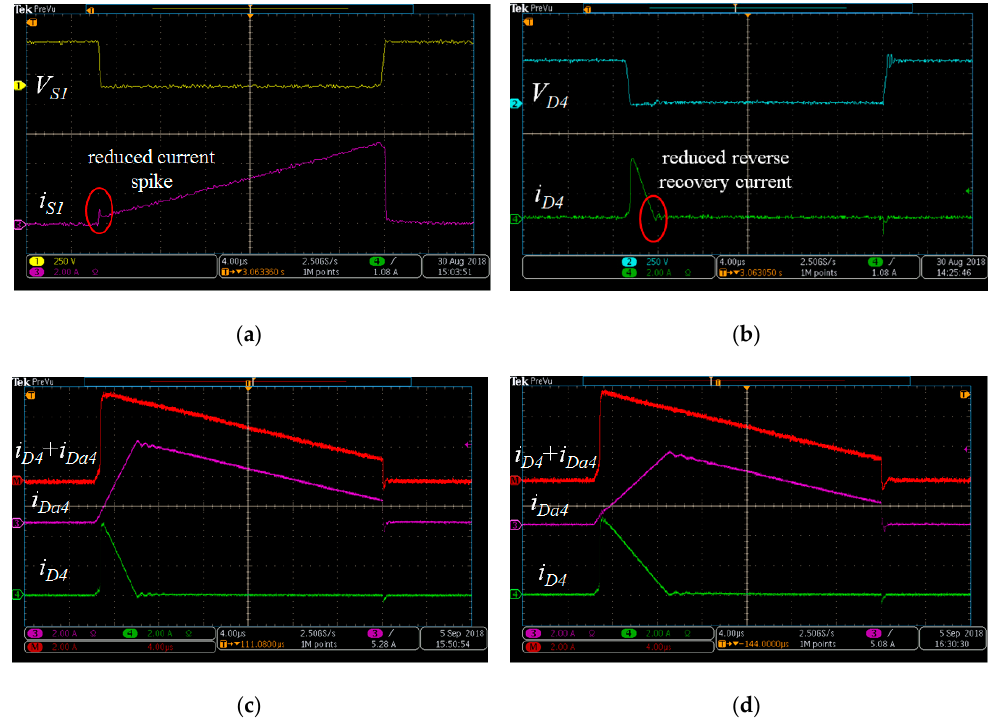
Figure 12. Experimental waveforms of the proposed inverter: ( a ) V S1 and i S1 ; ( b ) V D4 and i D4 ; ( c ) i D4 + i Da4 , i Da4 and i D4 with L k = 5 µH; ( d ) i D4 + i Da4 , i Da4 and i D4 with L k = 15